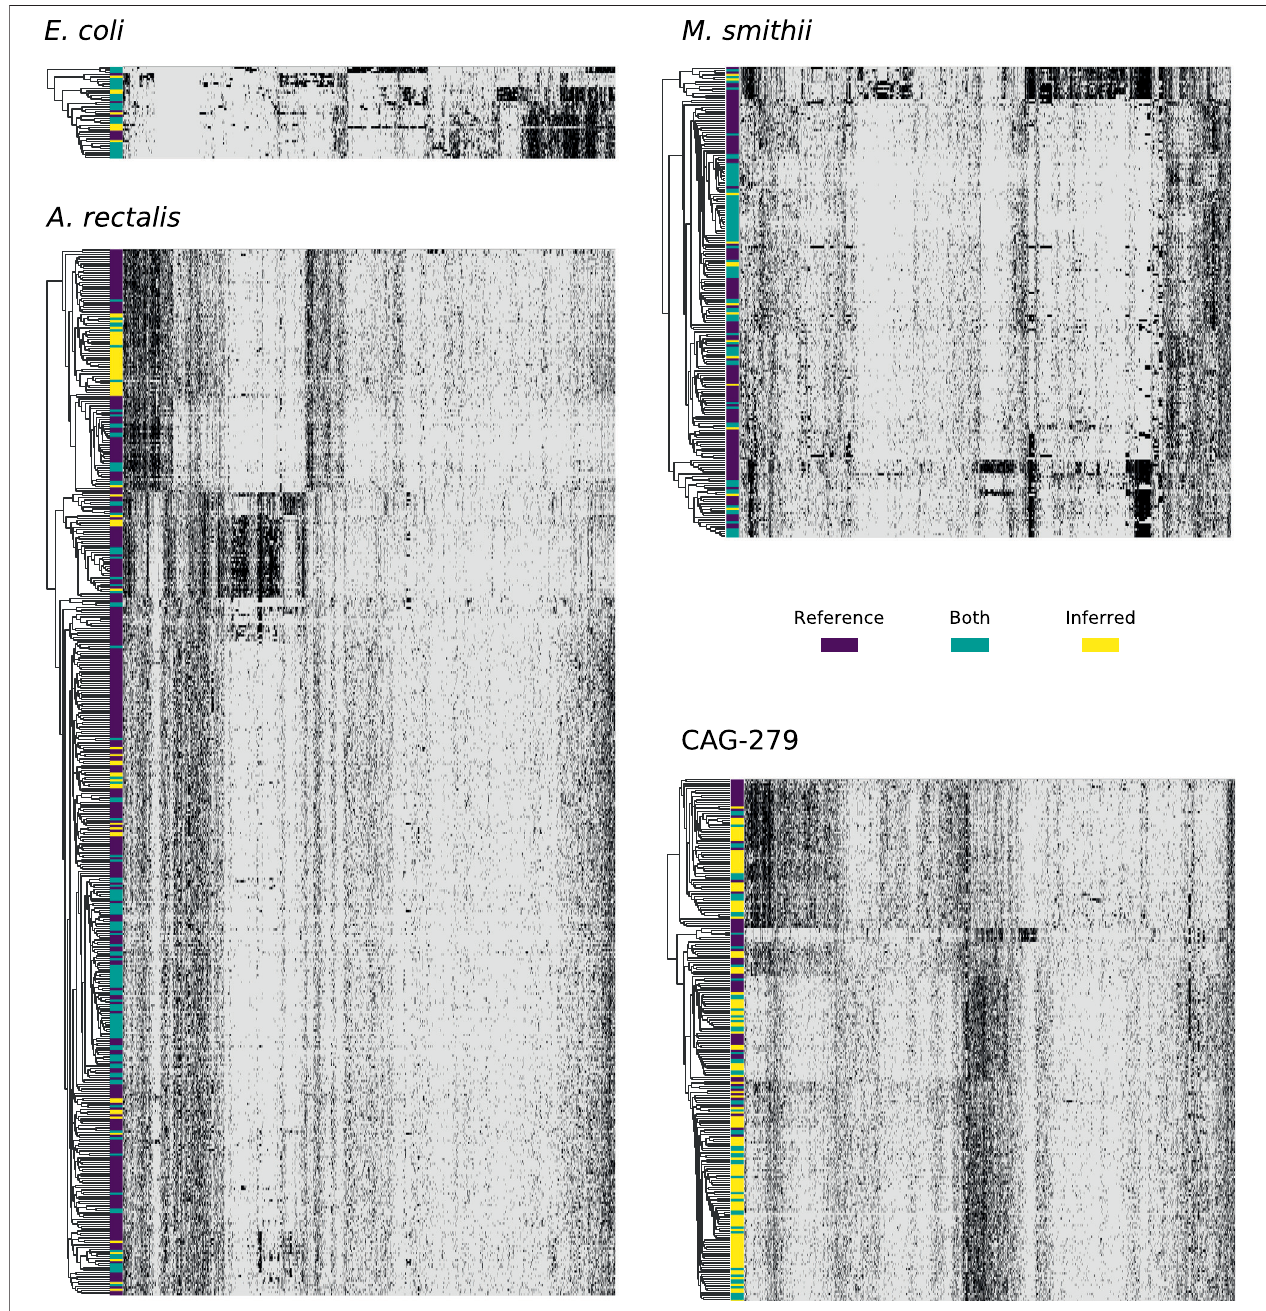
FIGURE 4 | Concordance between reference and StrainFacts inferred strain genotypes for four prevalent species in the human gut microbiome. Heatmap rows represent consensus genotypes from co-clustering of reference and inferred strains and columns are 3,500 randomly sampled SNP sites (grey: reference and black: alternativeallele). Colorstotheleftoftheheatmap indicate clusterswithonly reference strains(dark purple),only inferred strains (yellow), orboth (teal). Rowsareordered by hierarchical clustering built on distances between consensus genotypes and columns are ordered arbitrarily to highlight correlations between SNPs.